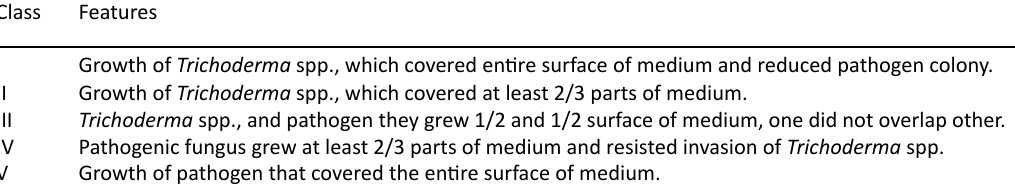
Table 1. Bell1 17 antagonism scale. Class